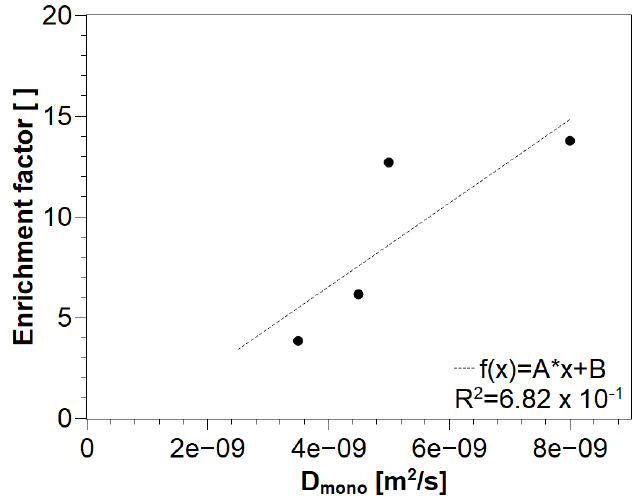
Figure 8. Correlation between diffusion coefficient of surfactants and enrichment of particles.